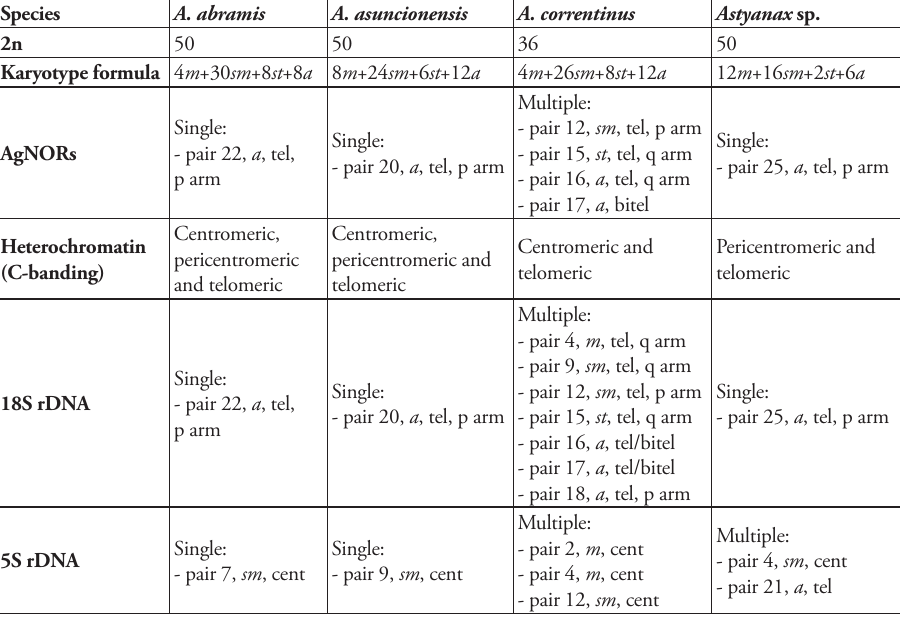
Table 1. Summary of the cytogenetical data for the Astyanax species analyzed in the present study.